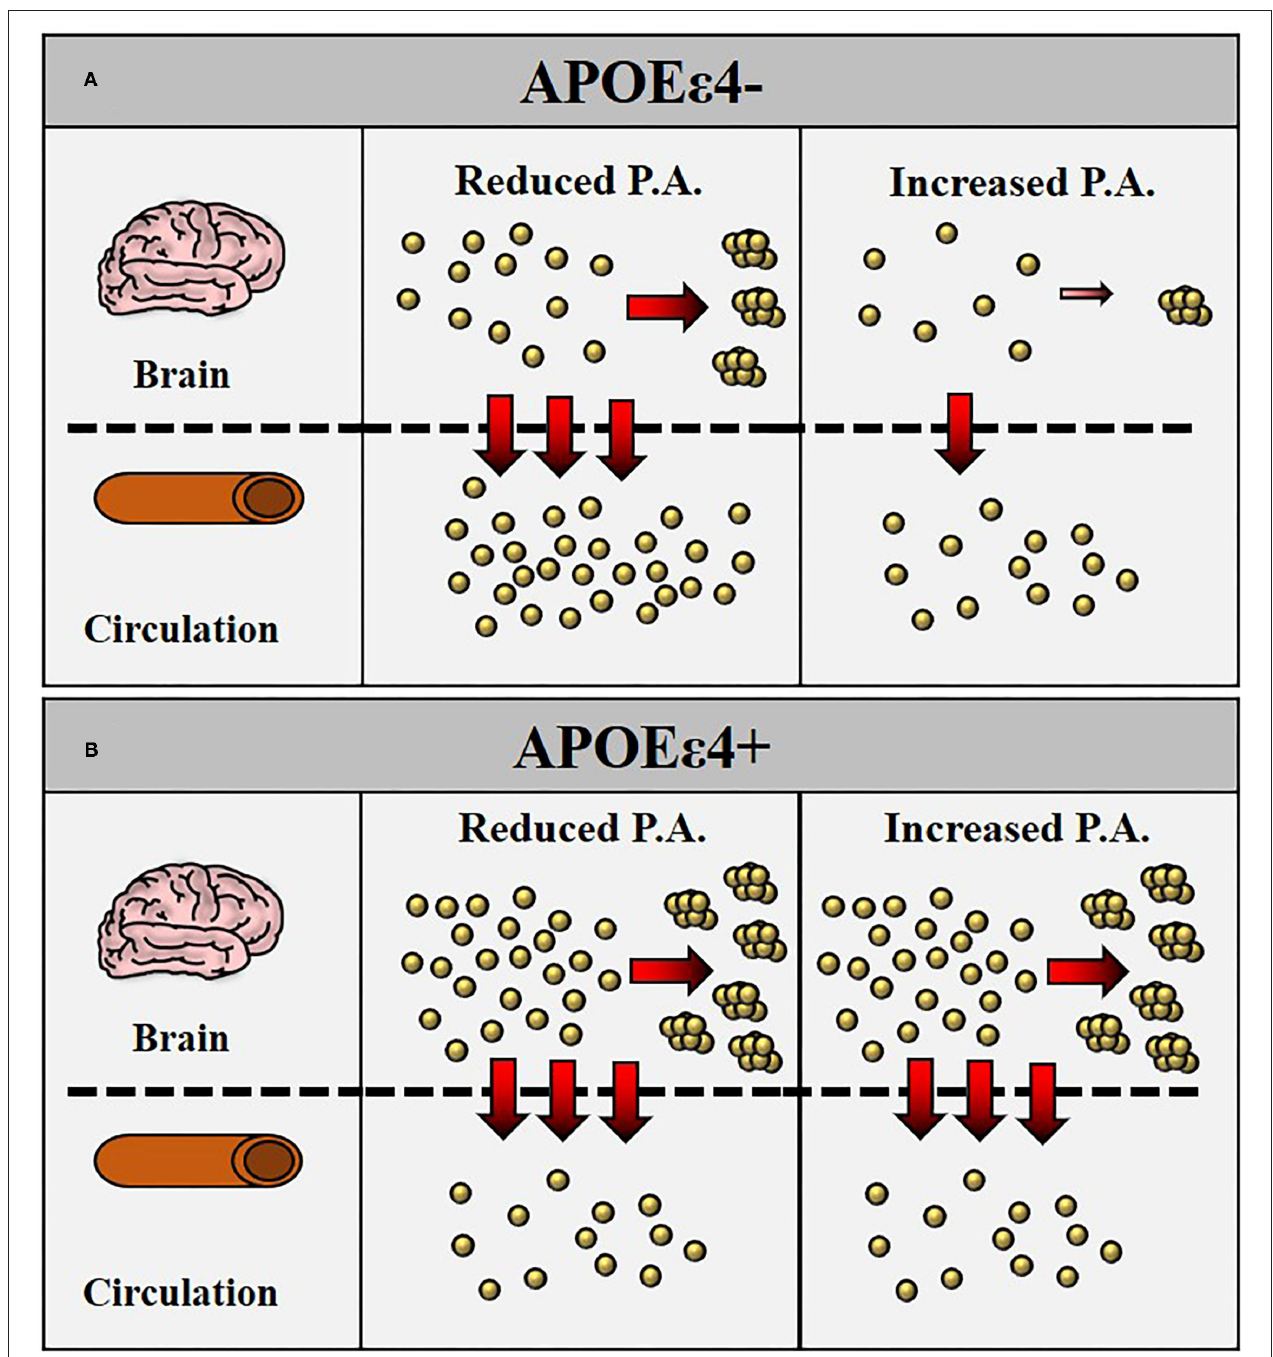
FIGURE 1 | Schematic representation of how physical activity (PA) may reduce A β generation with consequently reduced transport of A β 1 − 42 across the blood-brain barrier (BBB) into circulation. In apolipoprotein E (APOE) ε 4– (A) , increased intensity of PA is followed by a reduced generation of A β 1 − 42 with consequently reduced plaque formation in the brain and reduced transport of A β 1 − 42 in the bloodstream. In APOE ε 4 + (B) , the lower levels of A β 1 − 42 in the bloodstream are a consequence of increased A β 1 − 42 retention in the brain with greater plaque formation. The intensity of PA does not appear to affect A β 1 − 42 plasma levels.